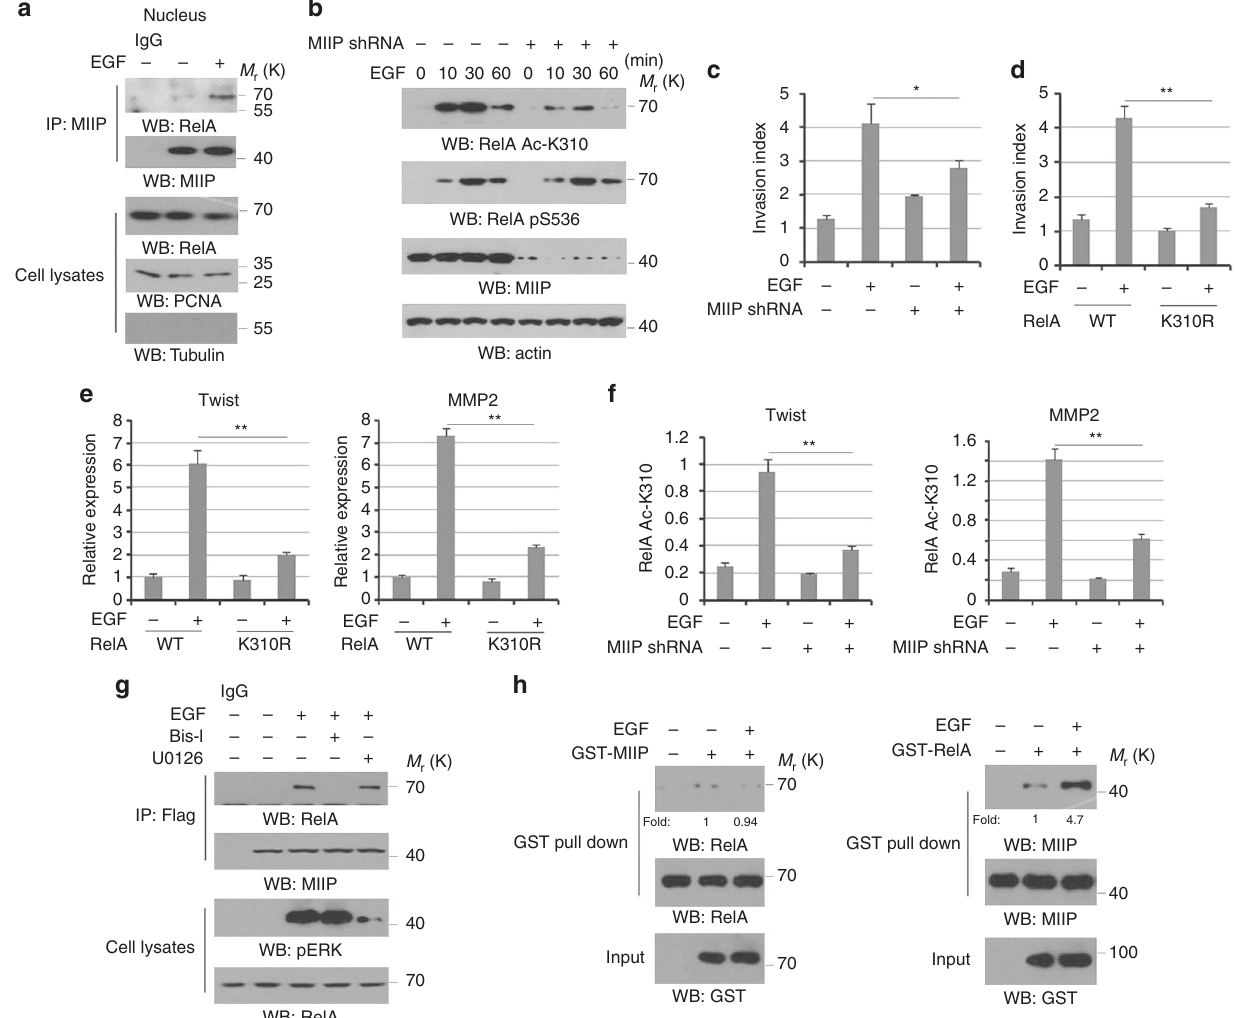
Fig. 1 EGF induced the interaction between MIIP and RelA. a HCT116 cells were treated with or without EGF. Cellular nucleus-extracts subjected to immunoprecipitation with an anti-MIIP antibody. b HCT116 cells transfected with or without plasmid for expressing the indicated MIIP shRNA were treated with or without EGF for indicated periods of time. c , d HCT116 cells transfected with or without plasmid for expressing MIIP shRNA ( c ), and HCT116 cells expressed with wild type (WT) RelA and RelA K310R ( d ) were treated with or without EGF (100 ng/ml). Cell invasion assays were performed. e HCT116 cells expressed with WT RelA and RelA K310R were treated with or without EGF (100 ng/ml) for 10 h. Relative mRNA levels were analyzed by q-PCR. f HCT116 cells transfected with or without plasmid for expressing MIIP shRNA were treated with or without EGF (100 ng/ml) for 10 h. ChIP analyses with an anti-RelA Ac-K310 antibody were performed. The primers covering RelA binding site of MMP2 gene promoter region were used for the q-PCR. The Y axis shows the value normalized to the input. g HCT116 cells were pretreated with Bis-I (2 μ M), U0126 (20 μ M) for 1 h, prior to EGF treatment (100 ng/ml) for 30 min. Cellular extracts subjected to immunoprecipitation with an anti-Flag antibody. h Puri fi ed GST-MIIP protein was mixed with mitotic extracts from HCT116 cells treated with EGF (100 ng/ml) for 30 min. GST pull down analyses were performed (left panel). Puri fi ed GST – RelA protein was mixed with mitotic extracts from HCT116 cells treated with EGF (100 ng/ml) for 30 min (right panel). In a , b , g , h , immunoblotting analyses were performed using the indicated antibodies and data represent one out of three experiments. In c – f , the values are presented as mean ± s.e.m. ( n = 3 independent experiments), * represents P < 0.05 and ** represents P < 0.01 (Student ’ s t -test) between the indicated groups NATURE COMMUNICATIONS | 8: 939 | DOI: 10.1038/s41467-017-01024-2 | www.nature.com/naturecommunications